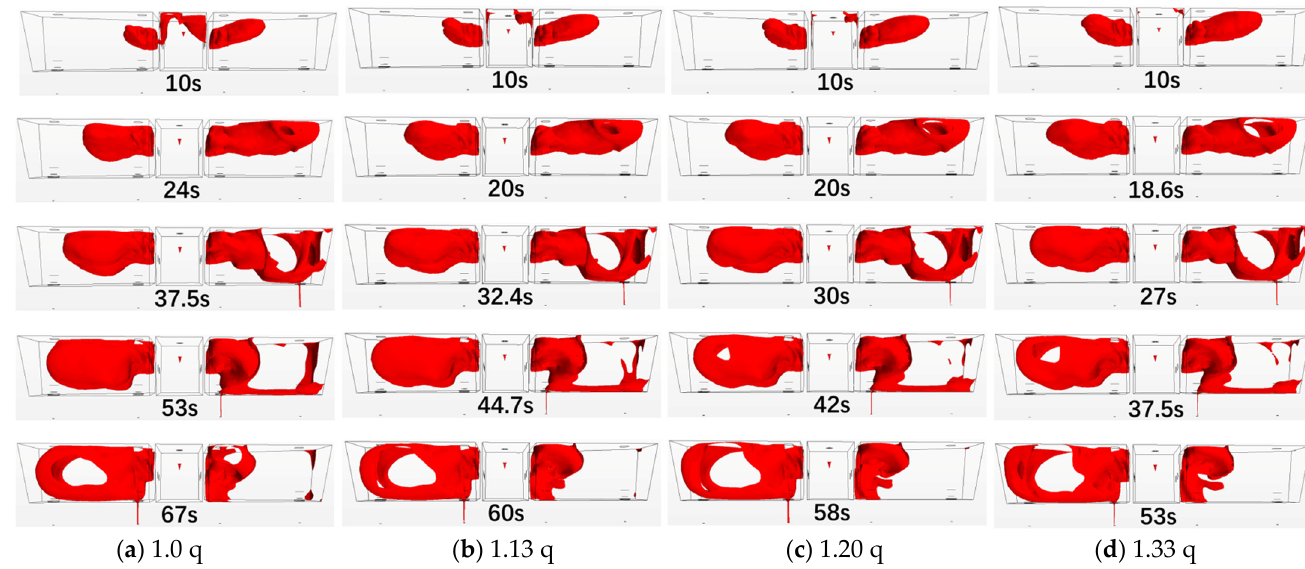
Figure 13. Isosurface evolution results of the double-weir tundish with uniform increasing casting flow rate under strand 1 blockage condition ( ω = 10 − 5 ).